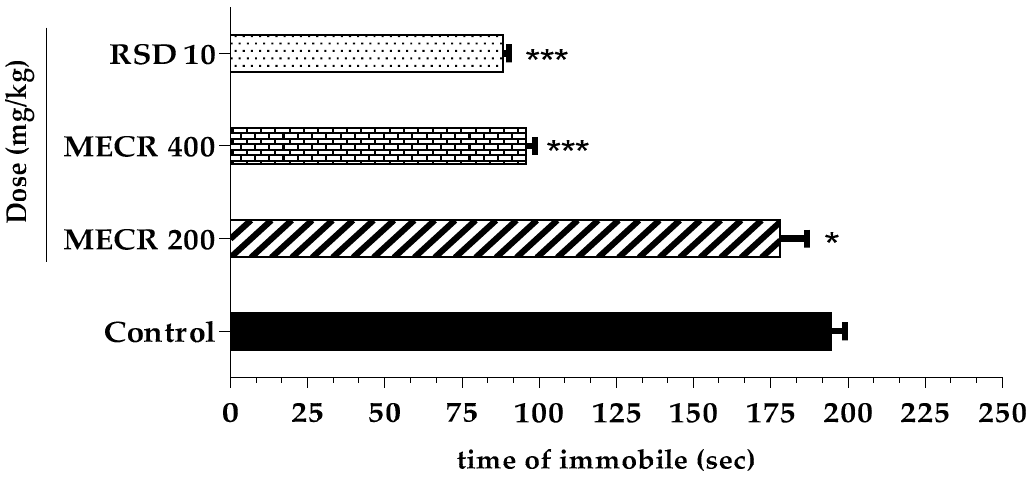
Figure 3. The effects of methanol extract of Cuscuta reflexa (MECR) in forced swimming test in mice. Values are expressed in mean ± SEM (n = 6). *p < 0.05 and ***p < 0.001 compared to control (Dunnett’s test). RSD: reference standard drug (Imipramine hydrochloride, 10 mg/kg). Tail Suspension Test